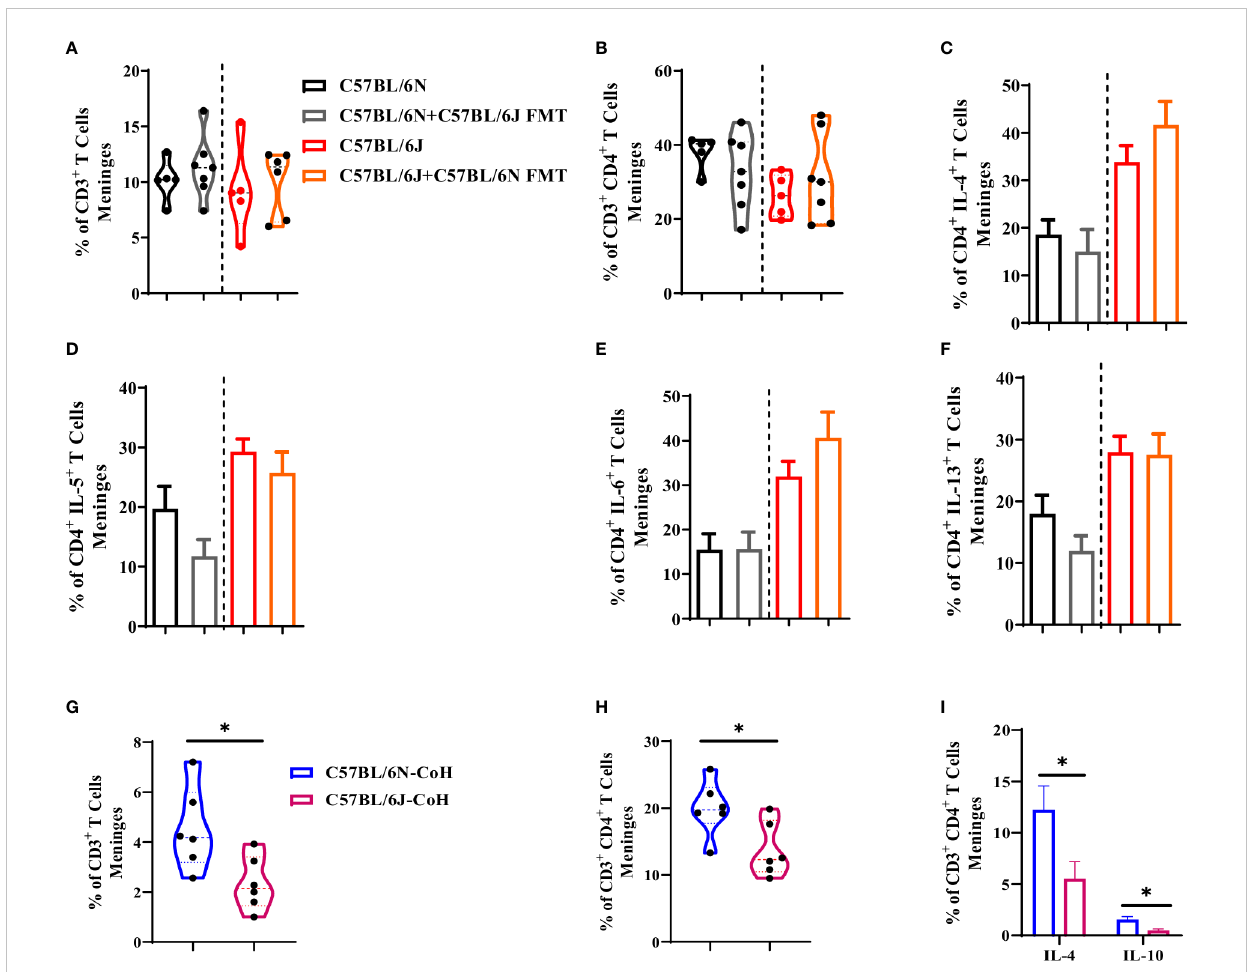
FIGURE 5 meningeal T cells are resilient to changes in microbial and environmental factors. (A) Frequency of CD3 + T cells, (B) CD4 + T cells, and (C) IL-4, (D) IL-5, (E) IL-6, and (F) IL-13-expressing CD4 + T cell in C57BL/6N and C57BL/6J upon FMT. (G) Frequency of CD3 + T cells, (H) CD4 + T cells, and (I) IL-4 and IL-10-expressing CD4 + T cell in C57BL/6 sub-strains after long-term environmental co-housing. Results are representative of three independent experiments with 5 – 7 mice/group. Data are expressed as mean ± S.E.M. *P < 0.05 by two-tailed unpaired Student